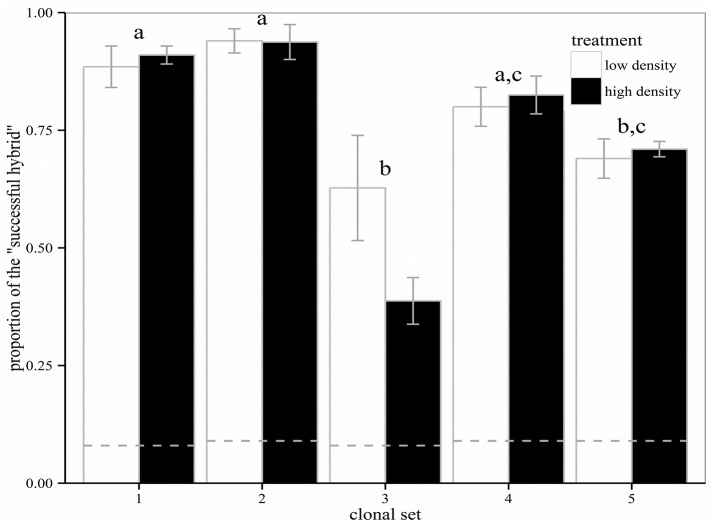
Competition experiment. Comparison of the final proportion of the “successful hybrid” among clonal sets (1–5) in two density treatments.Shown are the means ± SE. The dashed lines specify the starting proportions of the “successful hybrid”. The “successful hybrid” increased its abundance across all clonal sets and both density treatments. However, its final density differed across clonal sets (same letters above the columns indicate no significant differences between the respective clonal sets).